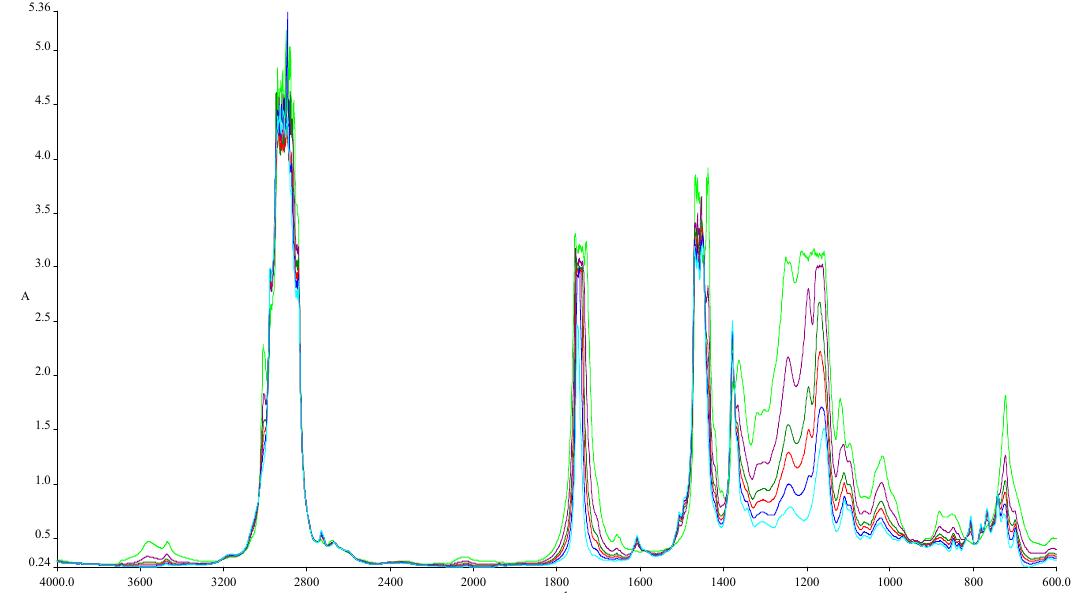
Figure 8. FTIR spectra of the blends (spectra of 100% biodiesel (BD) fuel—light green, spectra of 50% BD fuel—purple, spectra of 30% BD fuel—dark green, spectra of 20% BD fuel—red, spectra of 10% BD fuel—blue, and spectra of Jet A fuel (Kerosene) with 5% Aeroshell 500 turbine engine oil added—light blue). − 1 When the FTIR spectra are compared, variations appear at 1745.83 cm (C = O stretching), − 1 − 1 − 1 1030.98 cm , 1117.54 cm , and 1170.23 cm (C–O alkoxyl stretching), but their intensity di ff